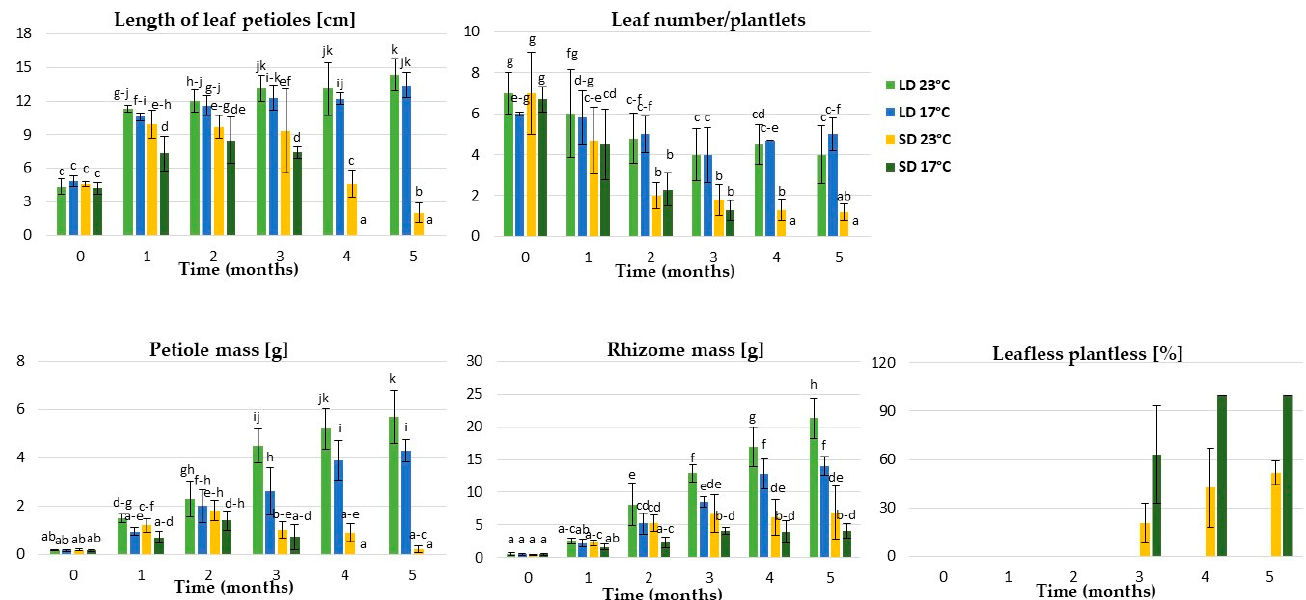
Figure 1. The effect of temperature (17 °C and 23 °C) and photoperiod (LD—long day, SD—short day) on ex vitro growth of micropropagated rhubarb ‘Raspberry’ plantlets after different growth periods (0, 1, 2, 3, 4 and 5 months) in the growth room. According to Duncan’s test ( p = 0.05), the means marked with the same letter within each growth parameter do not differ significantly. Error bars represent standard deviation.